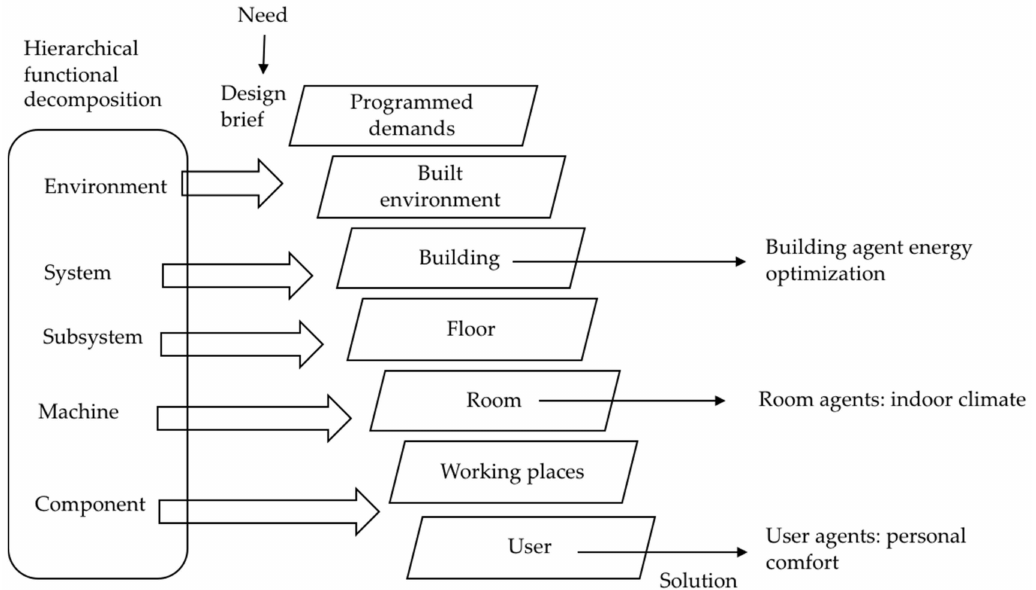
Figure 4. A hierarchical ontology for the energy supply structure of buildings